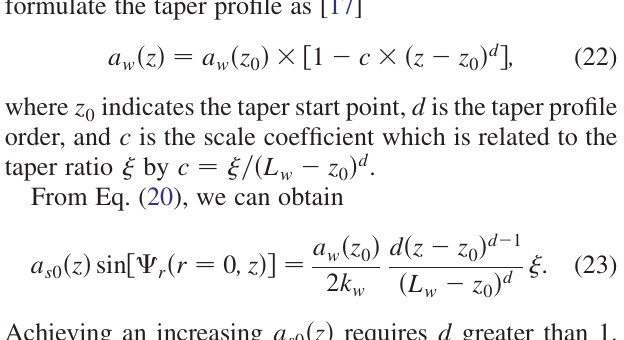
, and with taper profiles obtained from GINGER code’s KMR-based self-design taper b